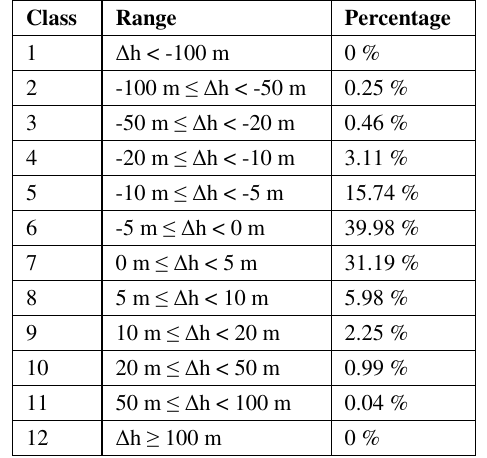
Table 5. Differences between LR Lombardy DTM and HR